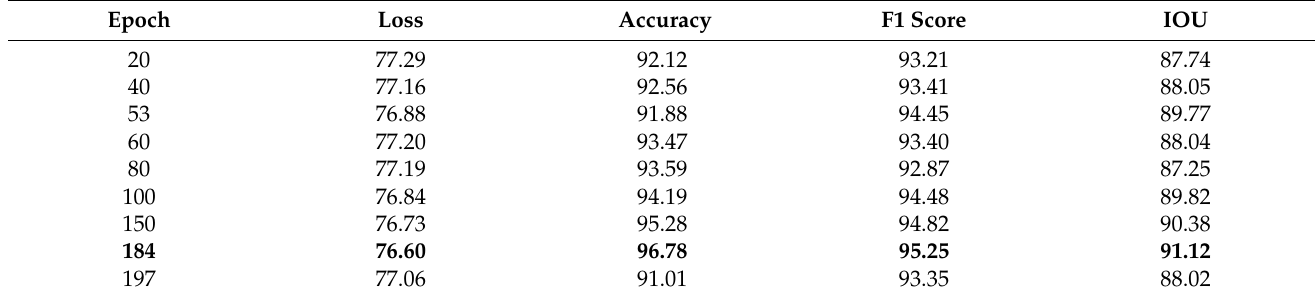
Table 7. Fit the model with different epoch values and analyze the